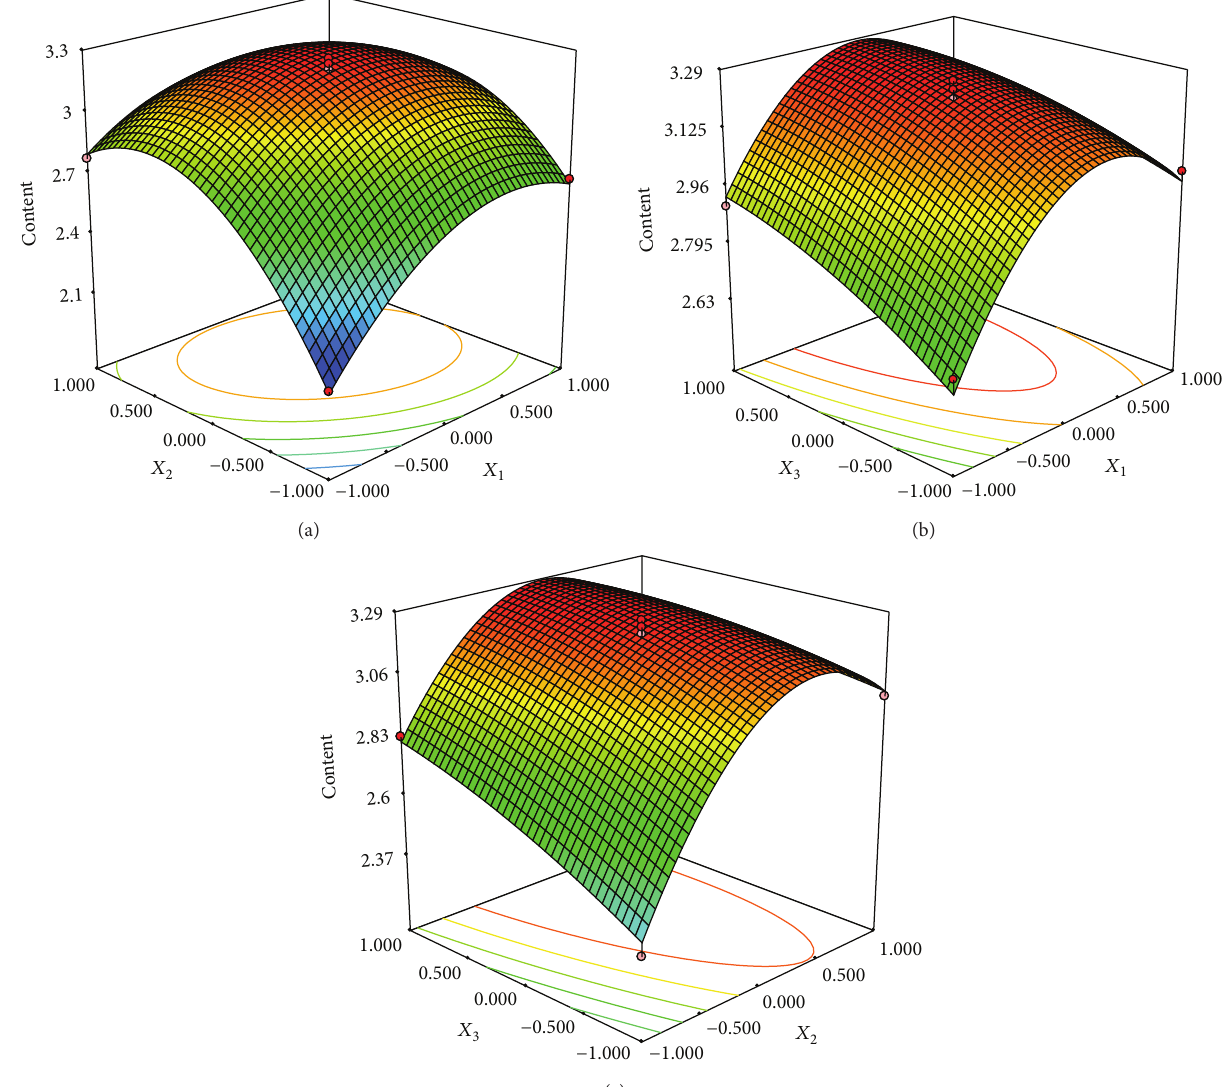
Figure 2: Response surface plots (3D) of reaction time, reaction temperature, and ratio of Na 2 SeO 3 to SFPSI ( 𝑋 1 : reaction time; 𝑋 2 : reaction temperature; 𝑋 3 : ratio of Na 2 SeO 3 to